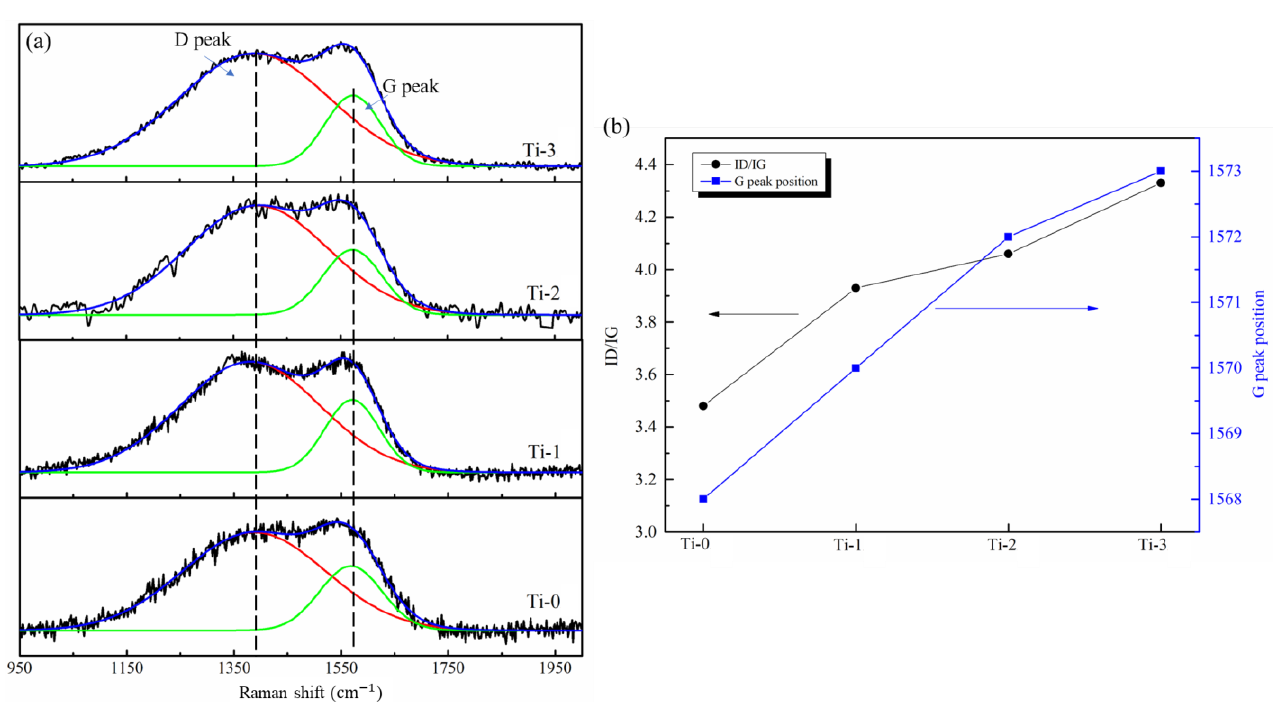
Figure 3. Raman spectra of amorphous carbon films: ( a ) Raman spectra ( b ) ID/IG and G peak posi- tion.